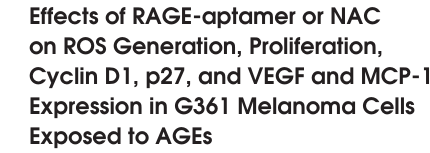
Figure 1. A, B. Biodistribution and time course kinetics of [ γ - 32 P]ATP-labeled RAGE-aptamer. Eight-week-old Balb/c-nu/nu mice received continuous intraperitoneal infusion of [ γ - 32 P] ATP-labeled RAGE-aptamer for 7 d. Then blood, urine and several organs were obtained at the indicated time periods. [ γ - 32 P]ATP-labeled RAGE-aptamer was detected and measured by Cherenkov counting. Results are presented as pmol per gram of each tissue. N = 4 for each